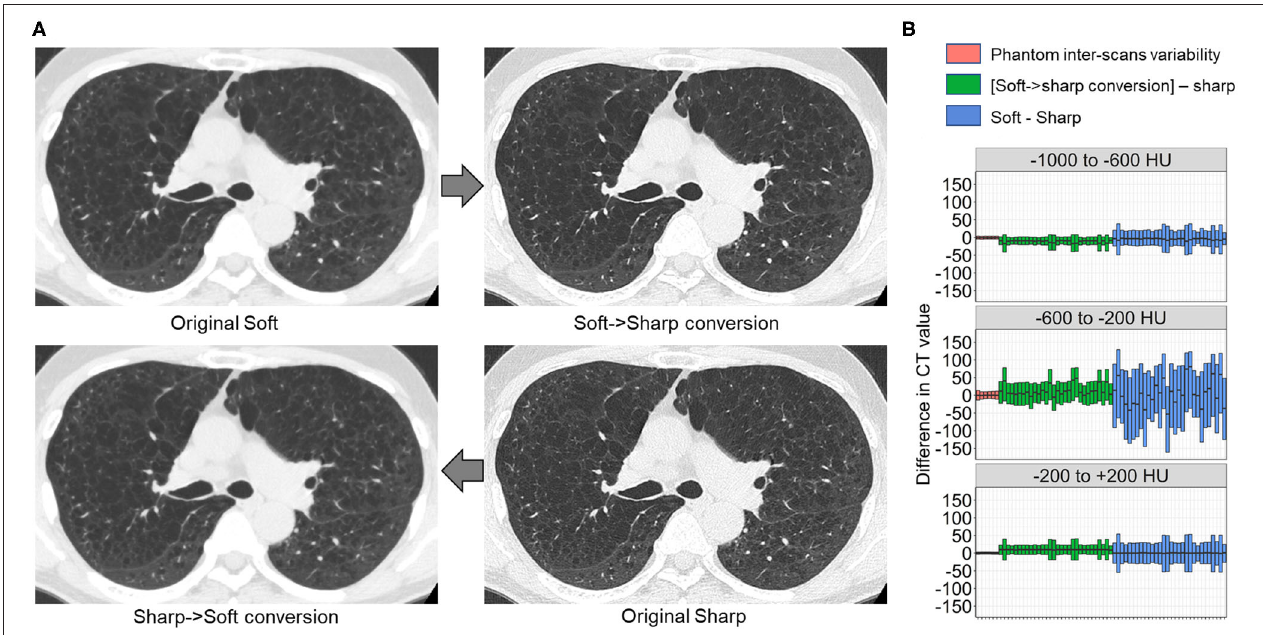
FIGURE 8 | Differences in CT values between deep learning-based kernel-converted (soft to sharp) images and ground-truth sharp-kernel images. (A) Deep learning-based soft-to-sharp conversion of original soft-kernel images to sharp-kernel-like images. Two deep leaning convolutional networks with and without truncation of CT values to − 300 to 300 HU (partial DNN and full DNN) were trained using pairs of soft-kernel images (input) and sharp-kernel-images (ground-truth), and output images from the partial DNN and full DNN were merged based on the same principle as sharp-to-soft conversion method. (B) Differences in CT values between converted images and ground-truth sharp images were compared to an inter-scans variability calculated from repeated phantom